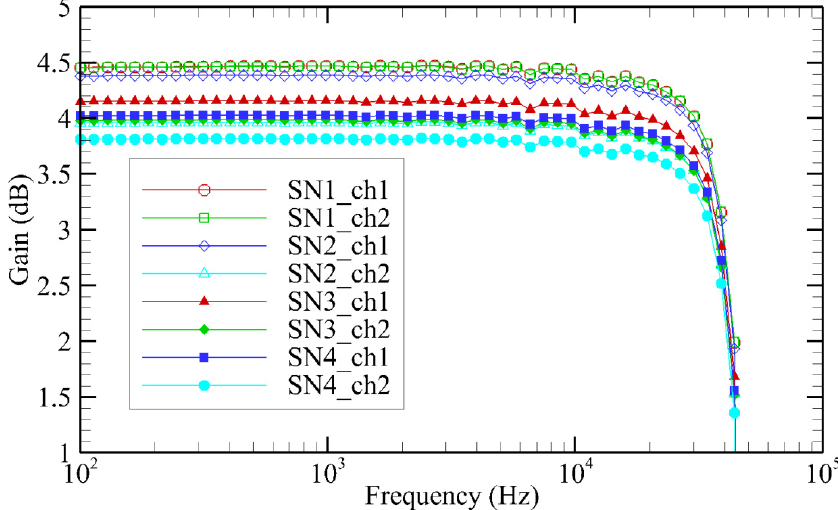
Figure 8. PCM-D50 data recorder frequency response for each channel of each unit tested.